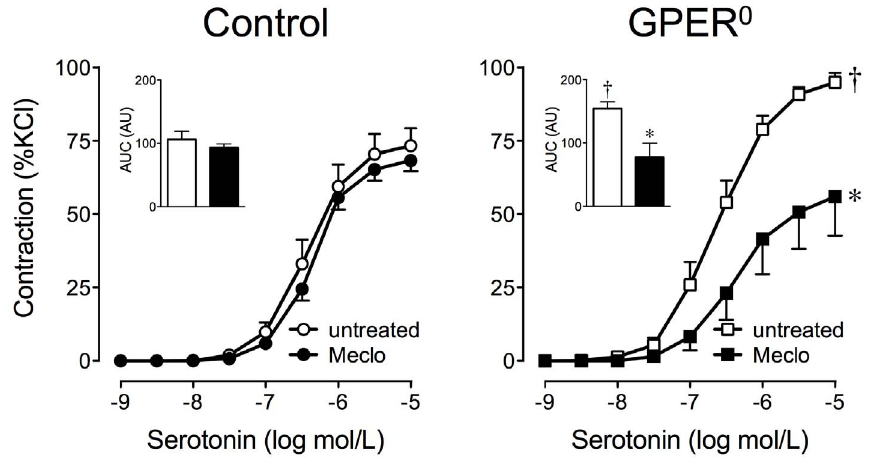
Figure 3. Cyclooxygenase inhibition prevents perivascular adipose-dependent potentiation of contractions to serotonin in monogenic obesity. Aortic rings with perivascular adipose (PVAT) from monogenic obese GPER 0 mice or lean WT (control) mice were pretreated with the cyclooxygenase inhibitor meclofenamate (Meclo, 1 m mol/L) prior to stimulation with increasing concentrations of serotonin. Inset: Area under the curve (AUC) of concentration-response curves is expressed as arbitrary units (AU). # , control, untreated ( n =6); , control, meclofenamate